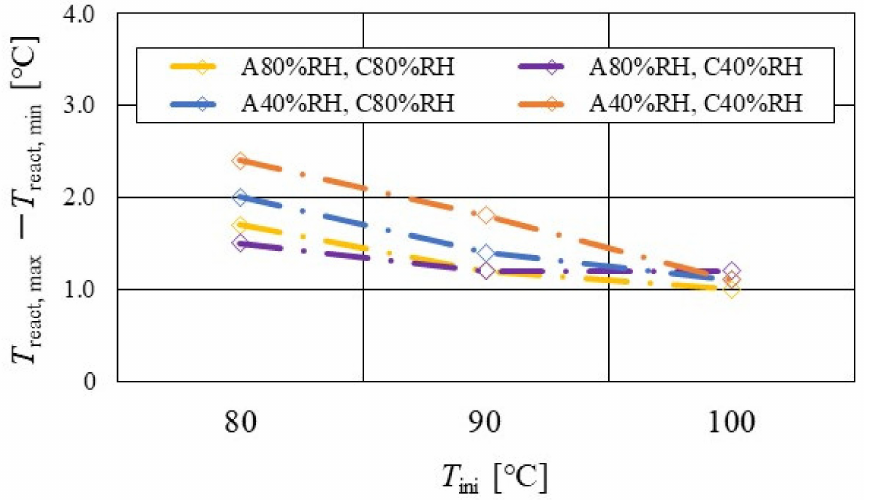
Figure 15. Effect of relative humidity and initial operation temperature and temperature difference, between the maximum and the minimum temperature in distribution of temperature at reaction surface, for the separator thickness of 1.0